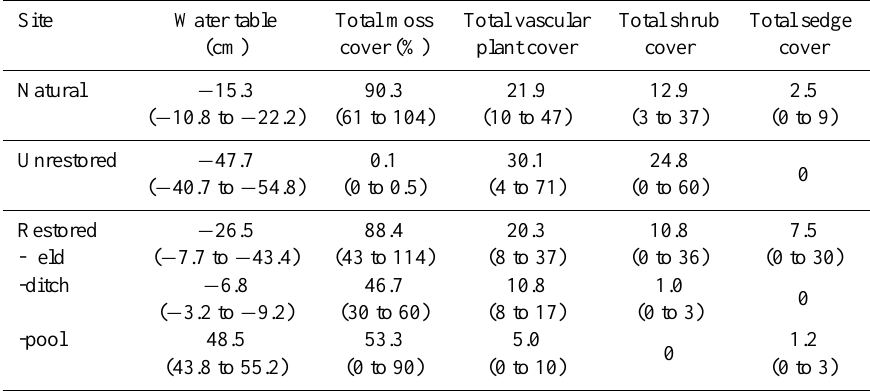
Table 1. Site characteristics a . Site Water table Total moss Total vascular Total shrub